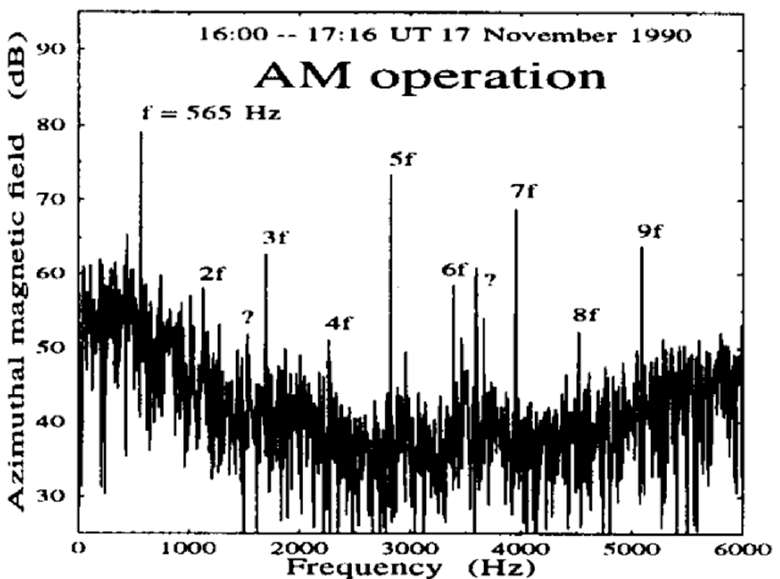
Figure 3. Amplitude spectra of the extremely low frequency (ELF) signals received at Lycksele (500 km south of the Tromsø heating facility), 17 November 1990, while the transmitter at Tromsø was operating in the Amplitude Modulation (AM) mode with a 565 Hz modulation frequency (reprinted from Journal of Atmospheric and Solar-Terrestrial Physics, 59, Barr, R., Stubbe, P., ELF and VLF wave generation by HF heating: A comparison of AM and CW techniques, 2265–2279, Copyright (1997), with permission from Elsevier [24]).